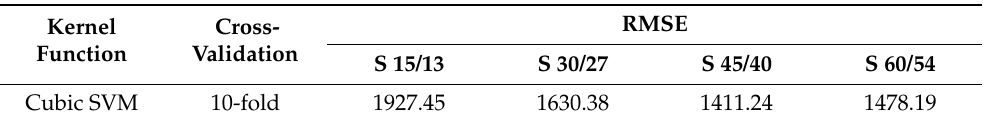
Table 3. Comparison of the performance of the support vector regression models with cubic kernel functions for different sets of samples using the root mean square error.